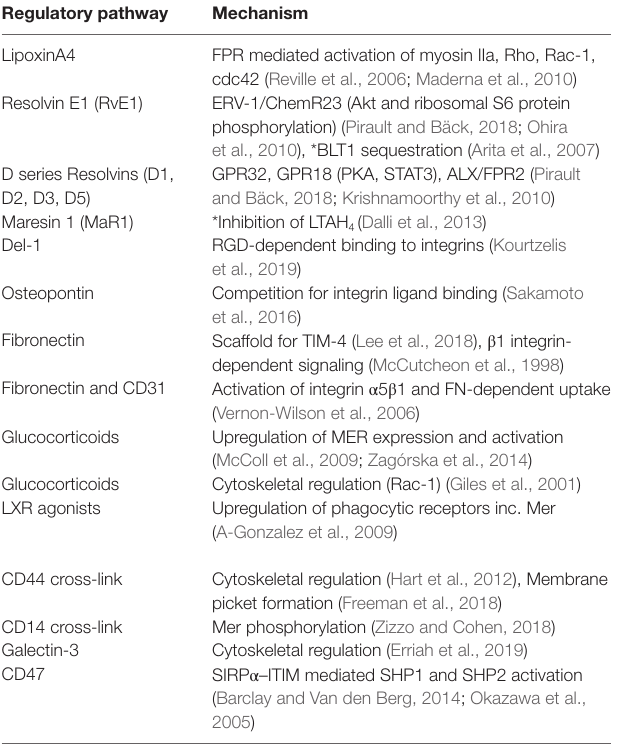
TABLE 2 | Summary of key mechanisms by which apoptotic cell phagocytosis is regulated. Examples of mediators that act to regulate phagocytosis of apoptotic cells, including putative mechanisms that are involved in